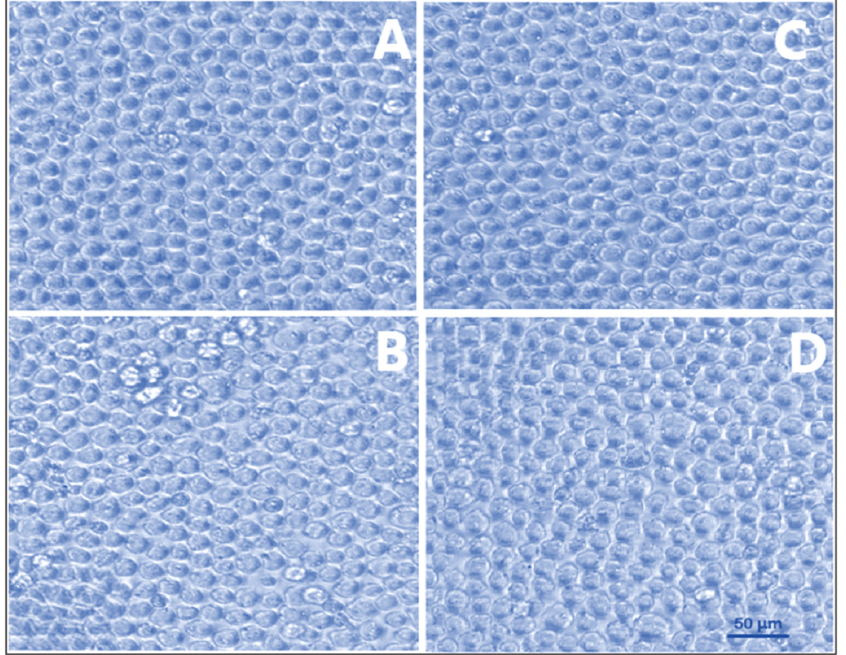
Figure 8. Morphological cellular appearance of human lymphocyte cells exposed for 72 h to materials and formulation such as ( A ) no treatment positive control, ( B ) only drug cytarabine, ( C ) neat TINPs, and ( D ) cytarabine ‐ loaded TINPs (CY ‐ TINPs).